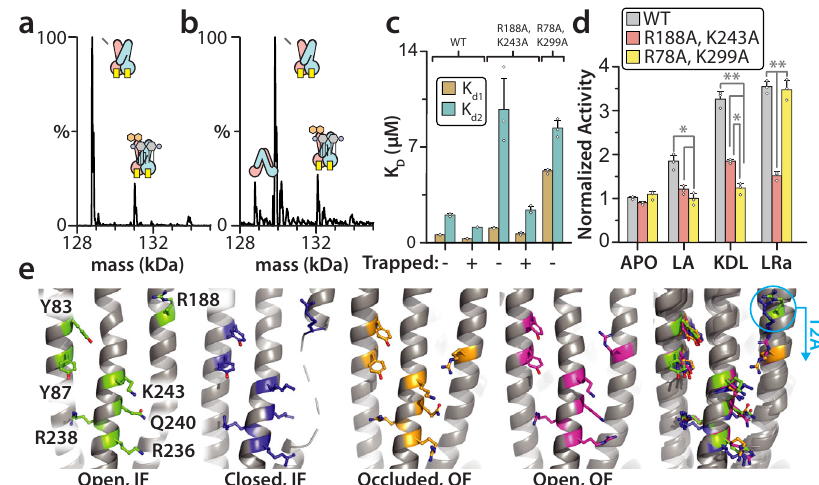
Fig. 6 | Characterization of the exterior KDL binding site. a Deconvoluted mass spectrum of 0.3 μ M MsbA R188A,K243A in the presence of 0.4 μ M KDL. b Deconvoluted massspectrumof0.4 μ Mvanadate-trappedMsbA R188A,K243A withsameconcentration ofKDLasinpanel a . c K D valuesforKDLbindingtothewild-typeandmutantMsbA. d ATPase activity of MsbA, MsbA R188A,K243A , and MsbA R78A,K299A in the presence and absenceof5 μ MlipidA(LA)( * p =0.047;0.011),KDL( ** p = 0.008;0.005, * p =0.019), orRa-LPS(LRa)( ** p =0.004;0.009).Atwo-sidedstudent ’ s t -testwasusedtotestfor